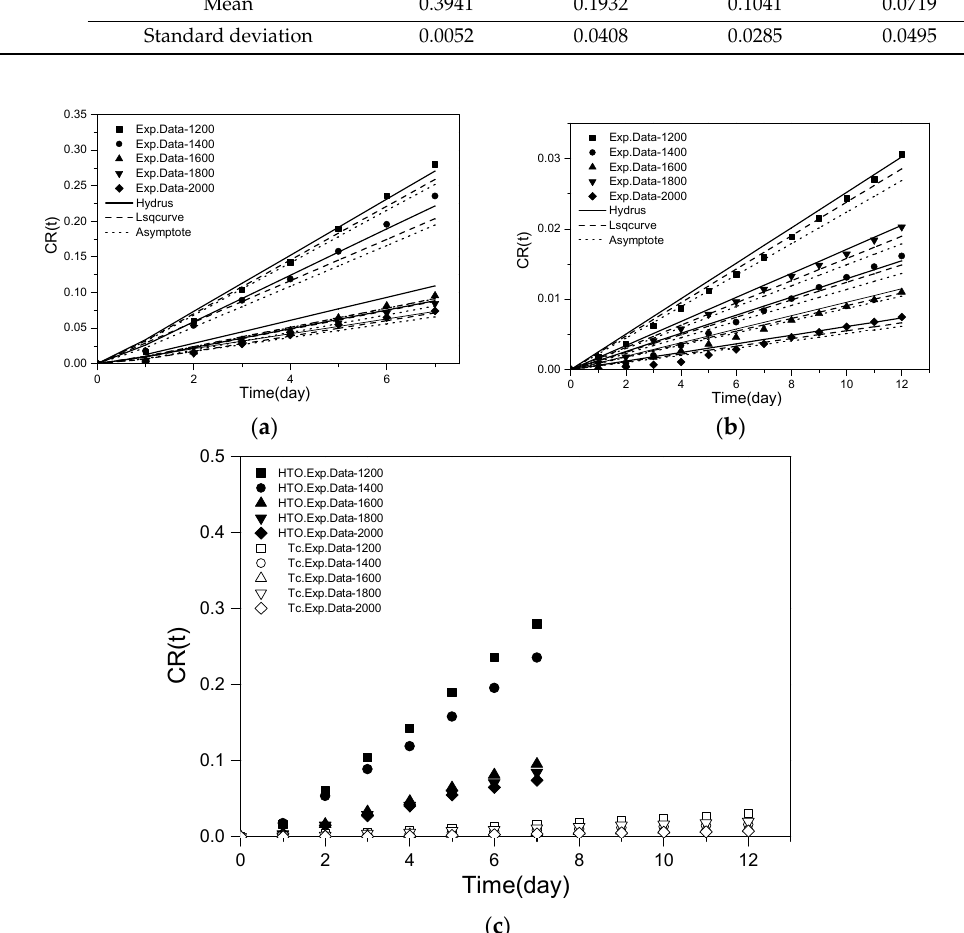
Figure 3. Various estimations of the comparable diffusion of HTO and Tc in bentonite compacted to various dry densities (1200, 1400, 1600, 1800, and 2000 kg / m 3 ) ( a ) HTO; ( b ) Tc; ( c ) HTO and Tc. Table 1. The through-diffusion conditions for the HTO and Tc in compacted MX-80 bentonite. Radionuclides Parameter (RN)